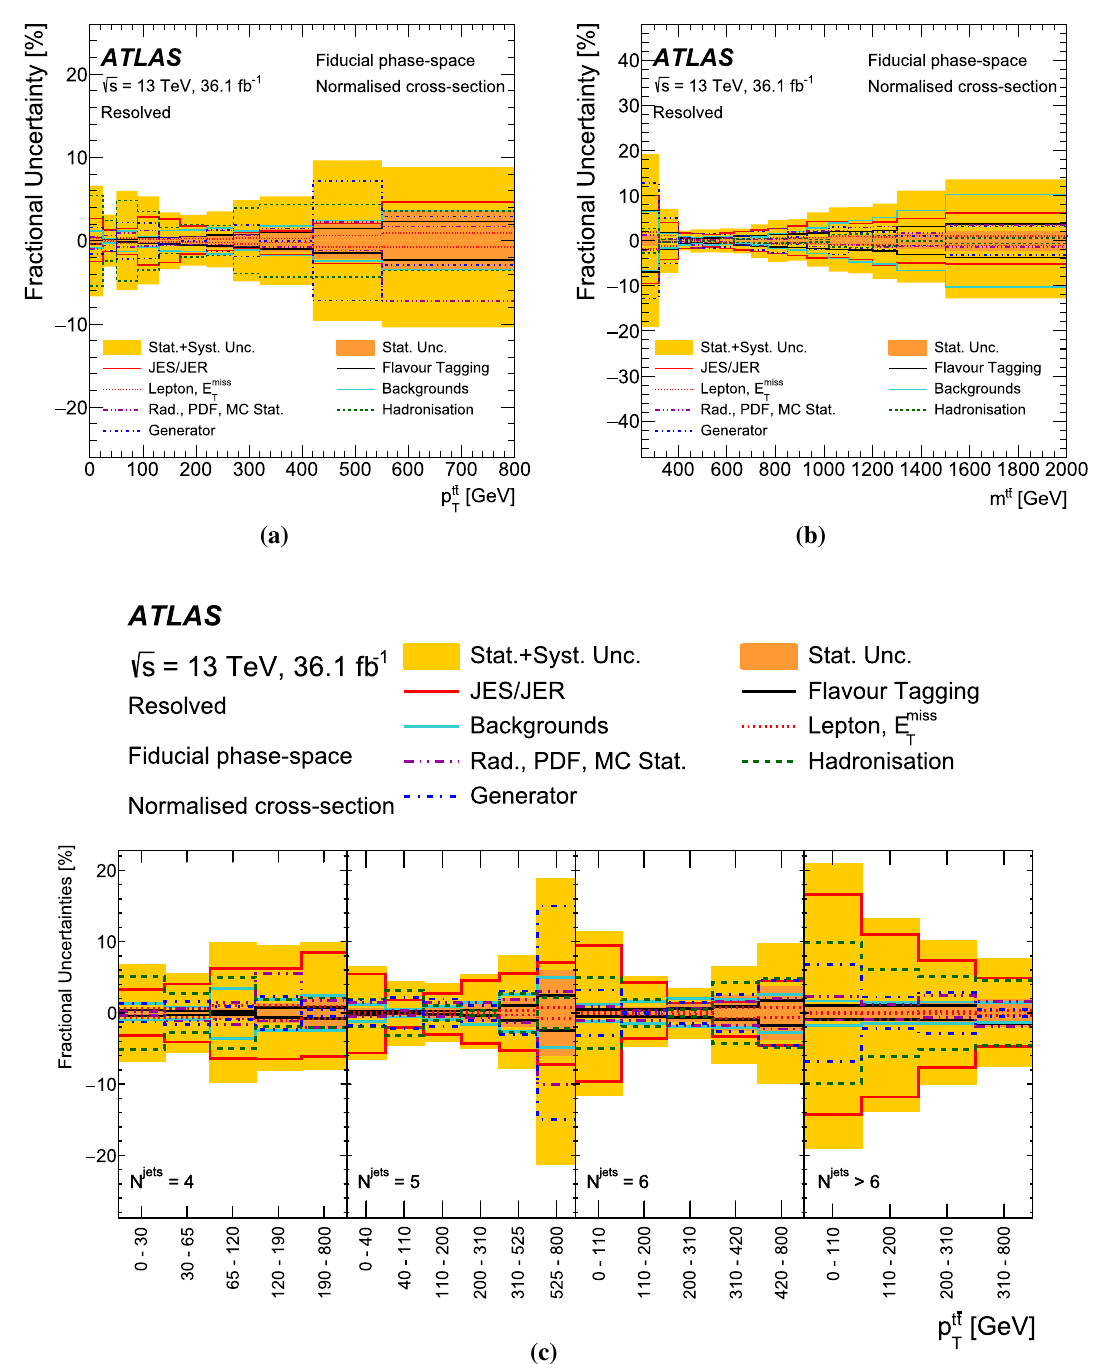
Fig. 18 Uncertainties in the particle-level normalised differential cross-sections as a function of a the transverse momentum, b the mass of the t ¯ t system, and c the transverse momentum of the t ¯ t system as